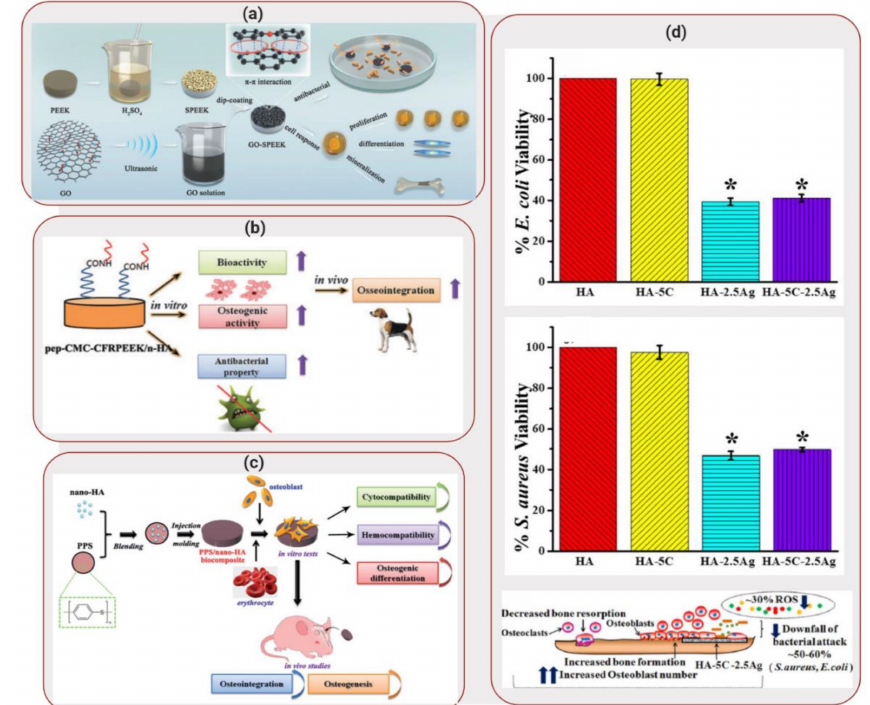
Figure 3. Applications of Biocomposites to Orthopedic / Dental Implants: ( a ) Schematic